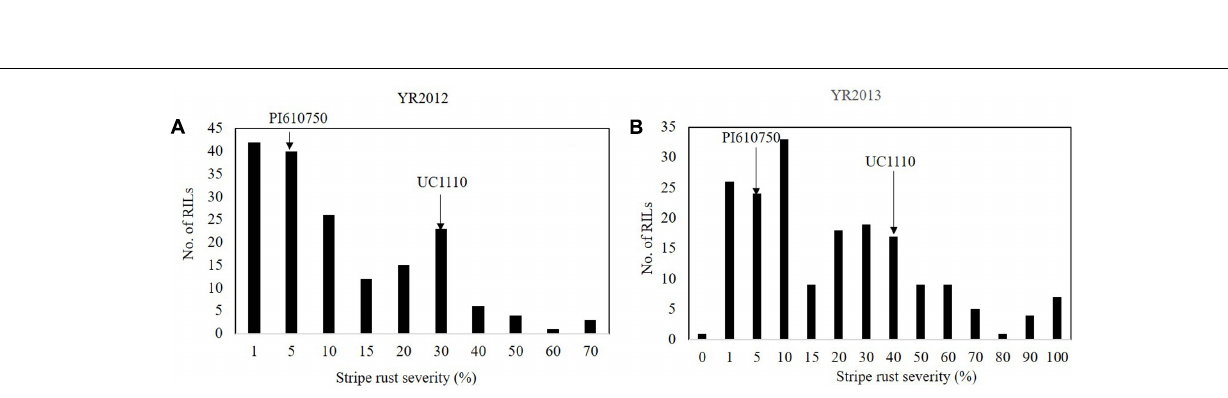
Frontiers in Plant Science |